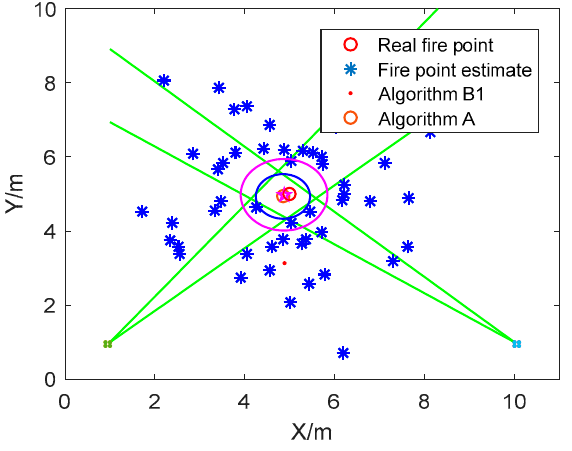
Figure 3. The circular fire source arrangement solved by Algorithm A and Algorithm B1. Table 3. The circle centers of real fire point and its estimates by Algorithms A and B1.